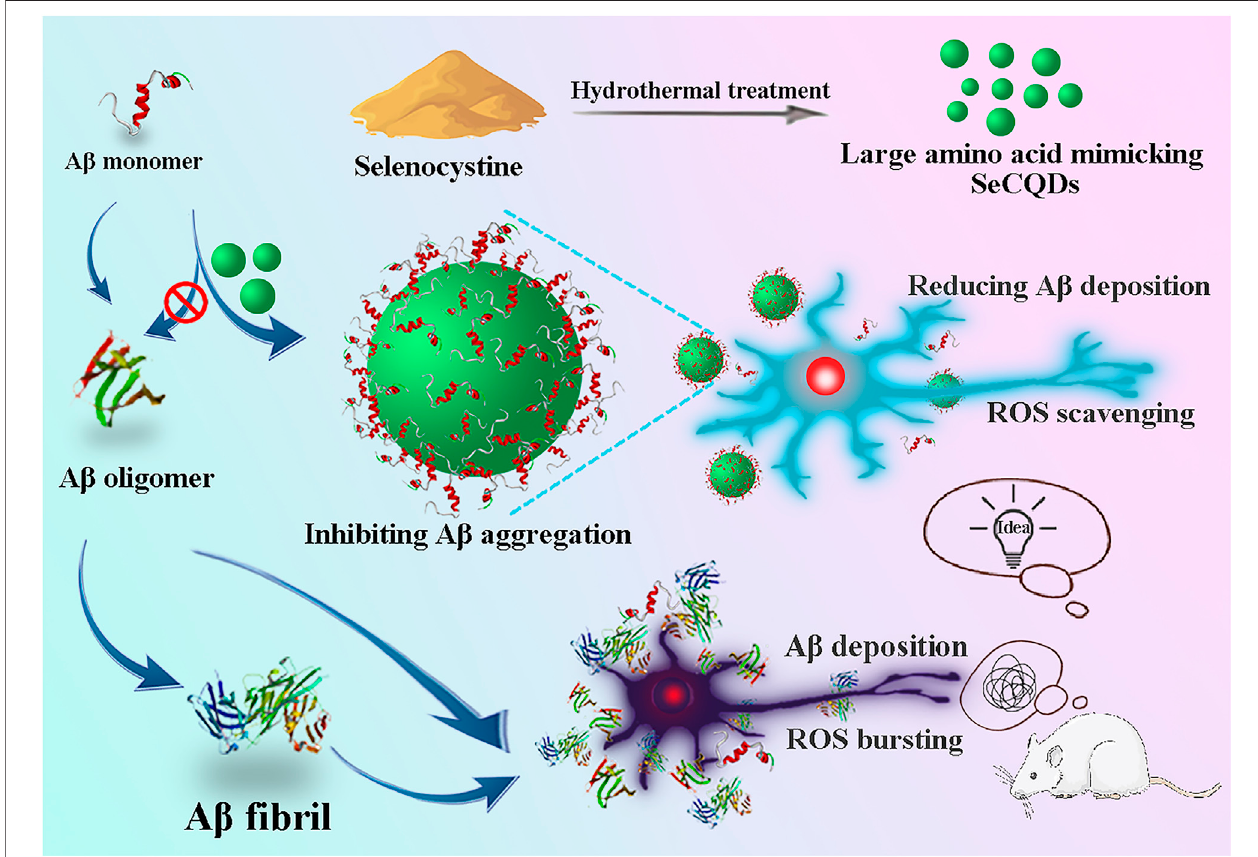
FIGURE 1 | Synthesis of SeCQDs and illustration of the inhibition effects of SeCQDs on A β aggregation and ROS production as well as mitigation of potential neurotoxicity in AD rat model.